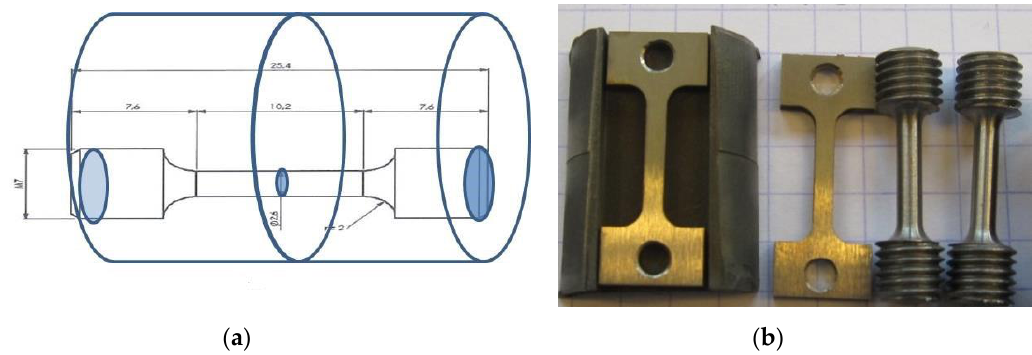
Figure 10. ( a ) Tensile testing samples were fabricated using electrical discharge machining (EDM) from the joined blocks. ( b ) Examples of flat and cylindrical tensile testing samples.